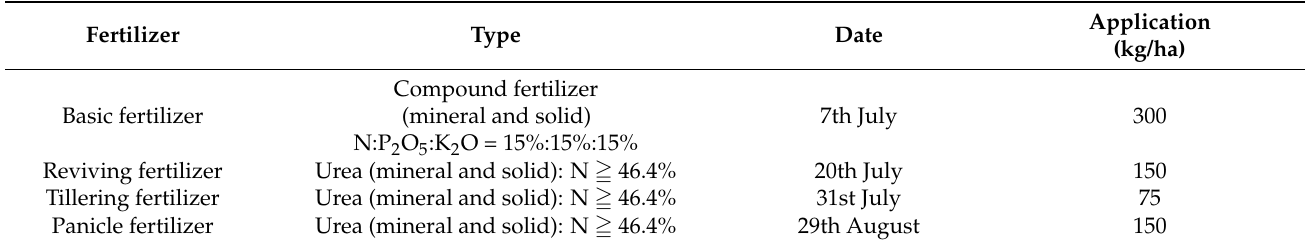
Table 2. Types and amounts of fertilizer applied in the different growth